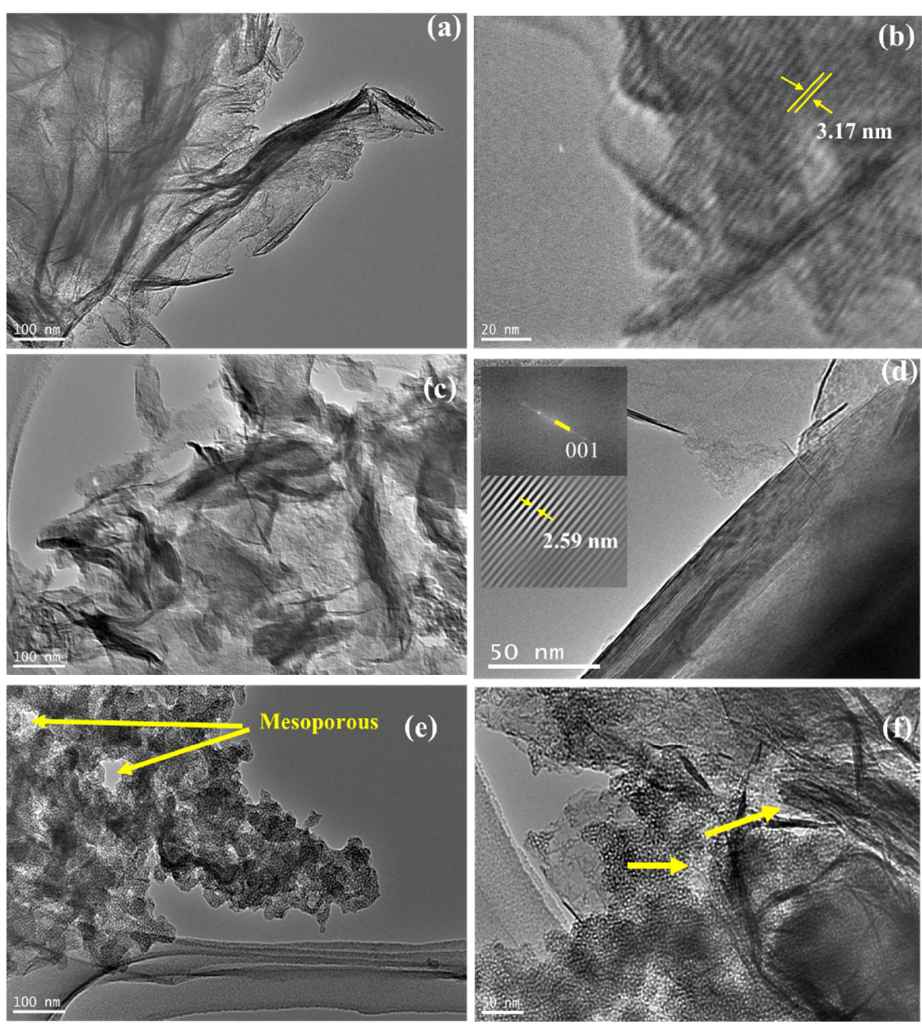
Figure 5. TEM images of: ( a , b ) PCH5/MW; ( c , d ) PCH10/HT; ( e ) PCH15/MW; ( f ) PCH15/HT.